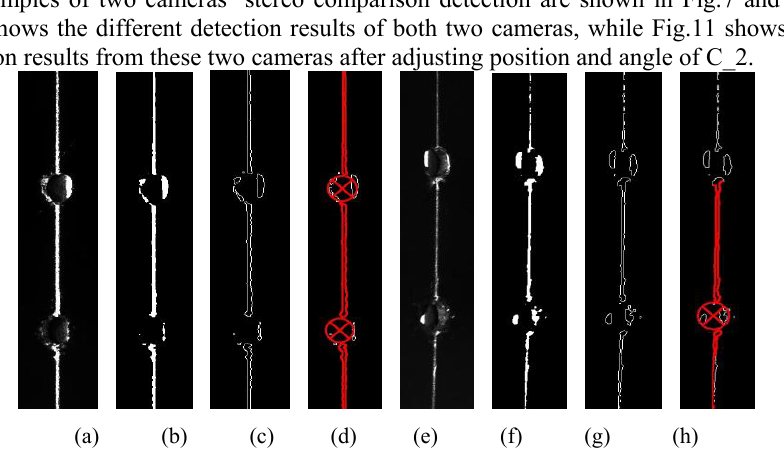
Fig. 7. Example of different detection results of two cameras.